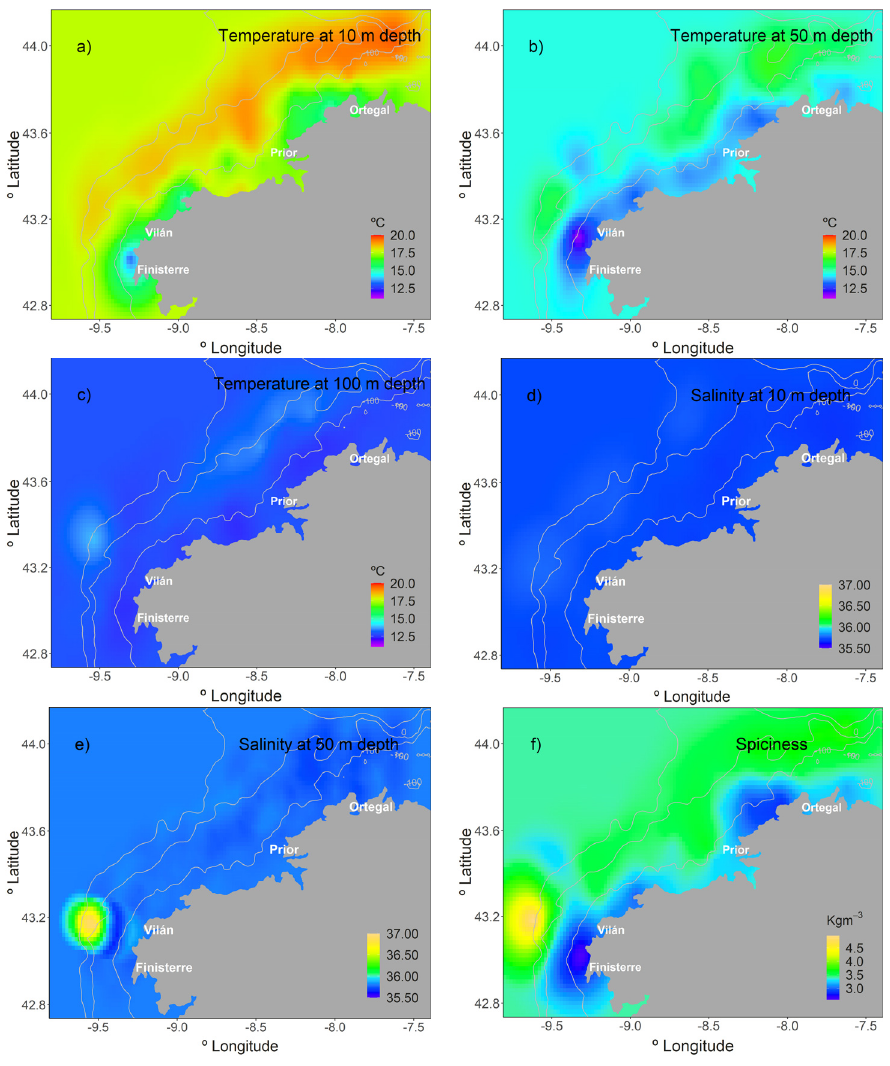
Figure 2. Temperature at depths of ( a ) 10 m, ( b ) 50 m, and ( c ) 100 m, salinity at depths of ( d ) 10 m and ( e ) 50 m, and ( f ) spiciness. The plot of salinity at 100 m is not shown due to its extremely low standard deviation (2.9).